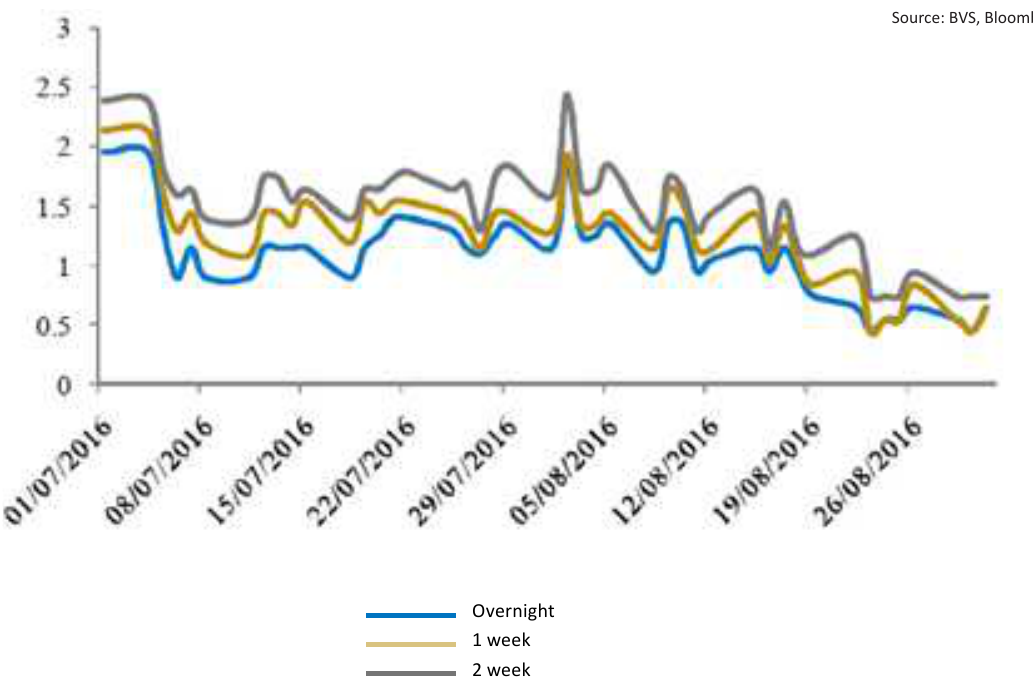
Figure B2. Interbank interest rate from July 1, 2016 to August 26,